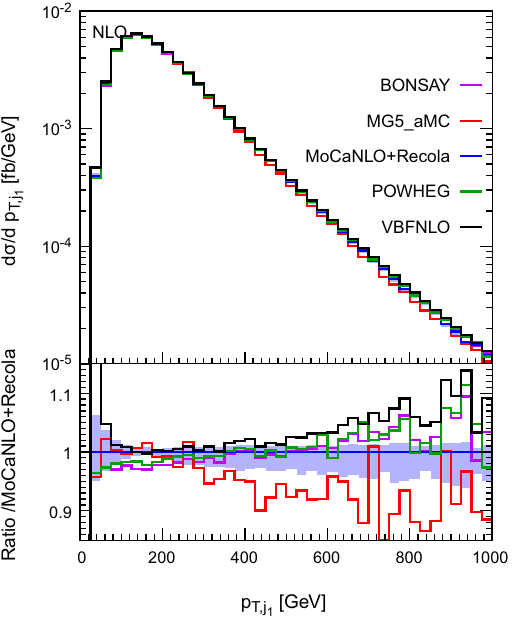
MoCaNLO + Recola which is the full prediction. The band corre- sponds to a seven-point variation of the renormalisation and factorisa- tion scales. The predictions are obtained in the fiducial region described in Sect.